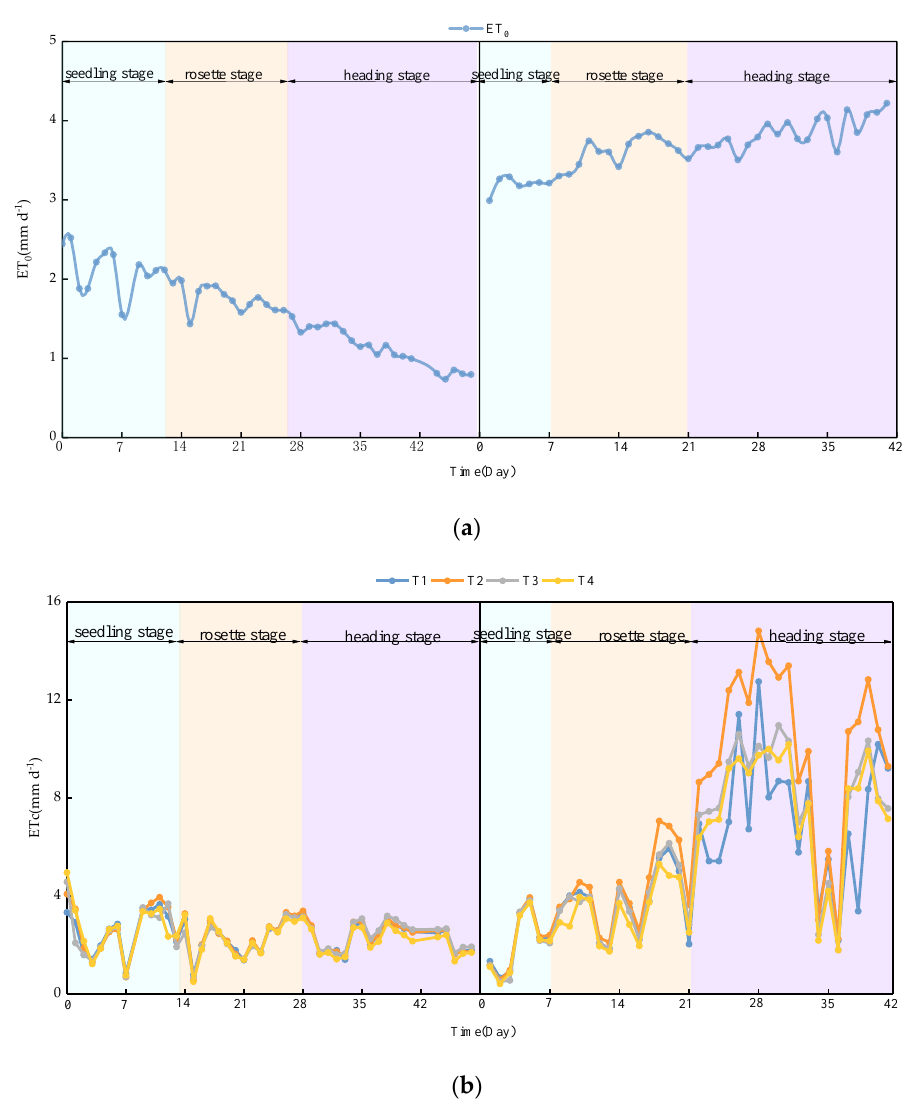
under T1, T2, T3, and T4 treatments in the second season are 1.38, 1.81, 1.47, and 1.38, respectively. Combined with the results of the first and second seasons, it can be seen that as the growth period advances, the K c of lettuce in the heading stage reaches the highest value, which is 2.26 and 2.56, respectively. Figure 11. ET 0 and ET c changes under different water treatments ( a ) ET 0 , ( b ) ET c . Based on the ET c calculated by IWS, and ET 0 calculated by the modified Penman – Monteith formula, the daily K c can be calculated as well. This reflects the K c changes of crops at different stages in real time. Figure 12 illustrates that the lettuce K c is different in different growth periods, and K c indicates a gradual increasing trend. Under different water treatments, the daily average K c of lettuce under T1, T2, T3, and T4 treatments in the first season are 1.64, 1.68, 1.67, and 1.57, respectively. The daily average K c of lettuce